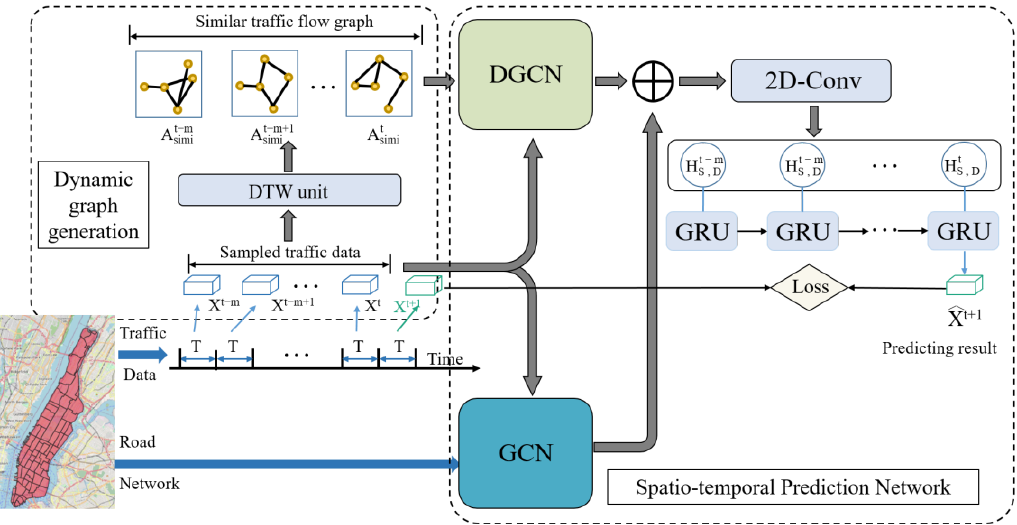
Figure 1. The framework of the HDGCN model.